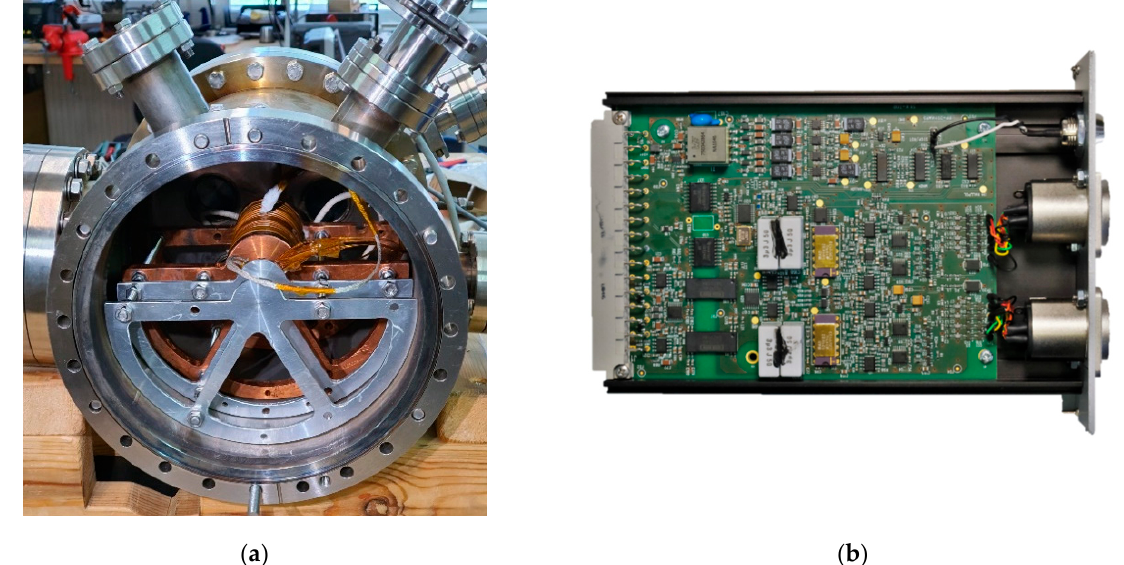
Figure 2. Experimental setup for high-temperature testing of the metal Hall sensors: ( a ) Vacuum oven with high-temperature solenoid with a button heater inside the solenoid; ( b ) Hall sensor controller card integrating a lock-in amplifier with a gain of 142,400.